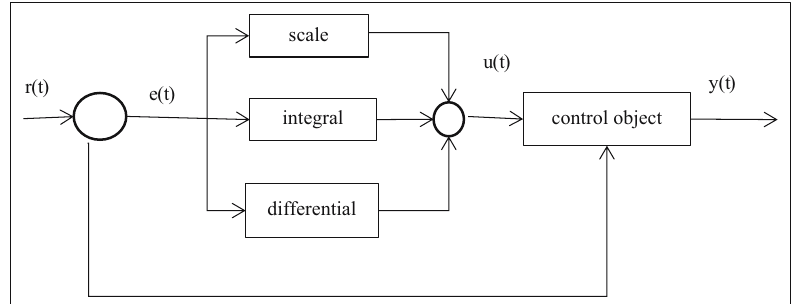
Figure 1: PID control